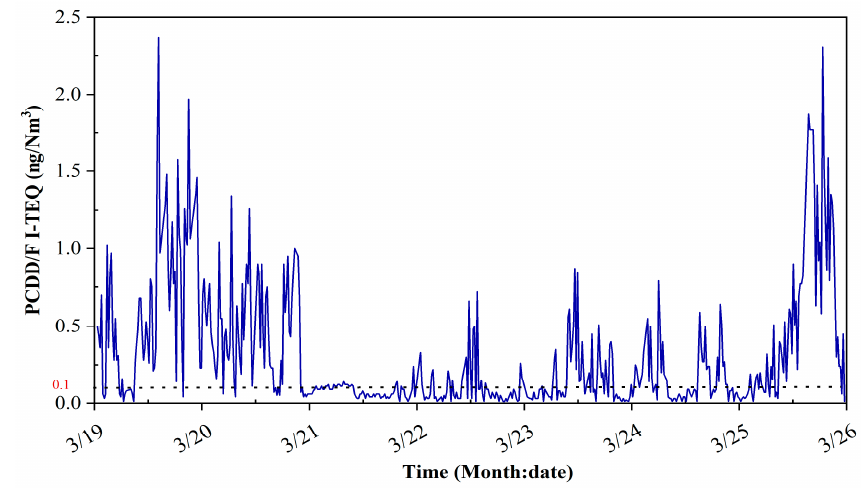
Figure 3. PCDD/F I-TEQ during the 168 h experiment.